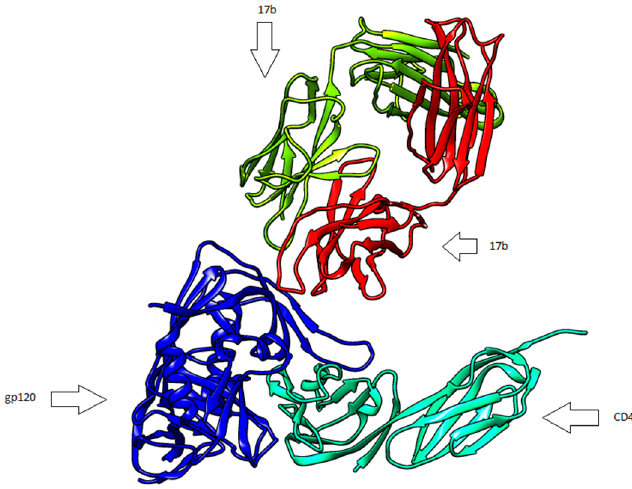
Figure 1. gp120 glycoprotein in complex with CD4 and an antibody (17b) (Protein Data Bank entry 1GC1).